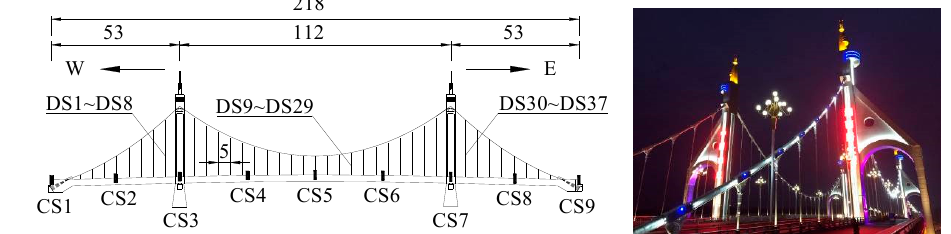
Figure 1. Global layout of the Hunan Road Bridge (Unit: m).